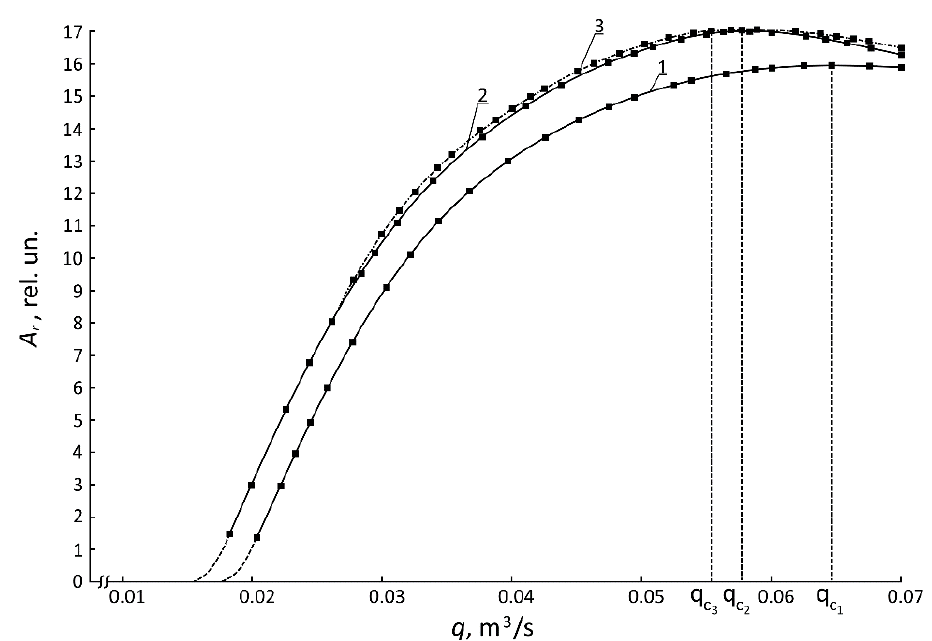
Figure 7. Dependence of the change of A r on coolant consumption q c . The graphs 1, 2, and 3 corresponds to the value of T in K: 303.2, 333.5, and 344.6.